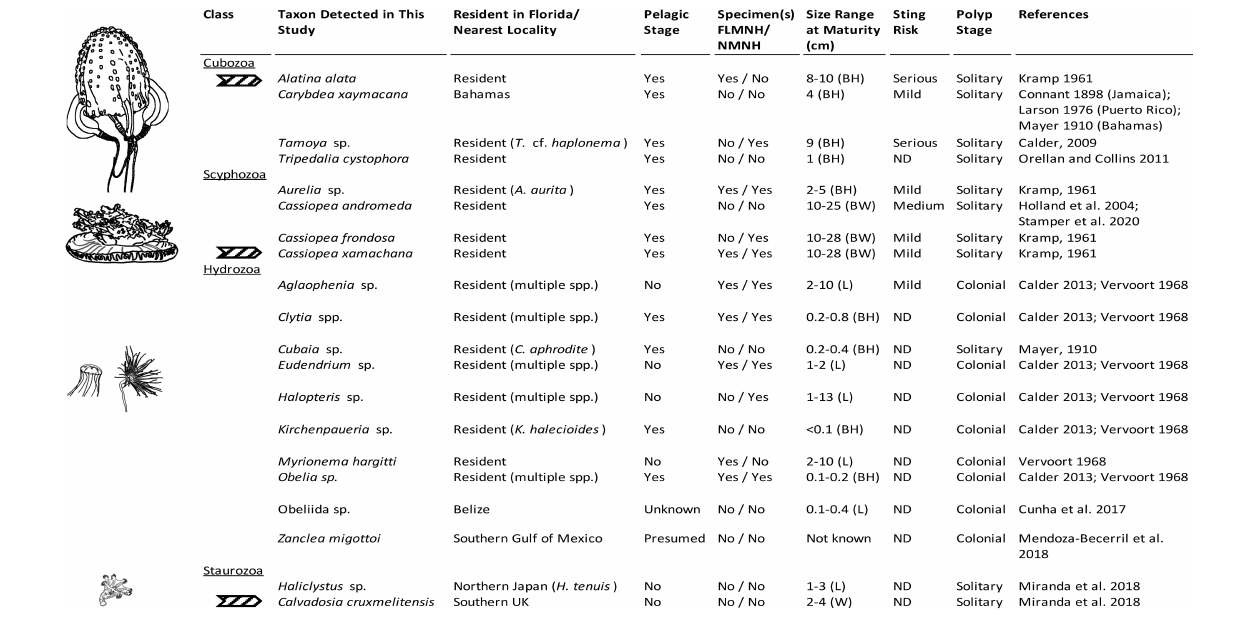
identity to the T. cf. haplonema rRNA gene from New